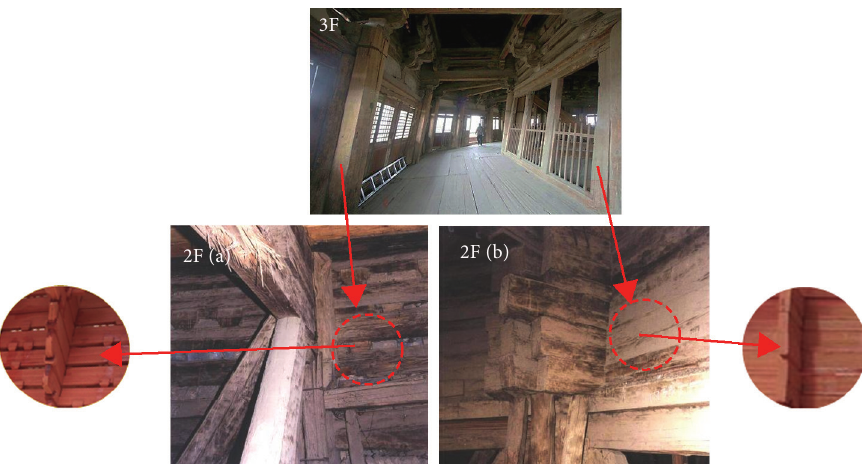
Figure 6: Beam construction under the (a) outer and (b) inner columns. Table 1: Measured relative dead loads of the column